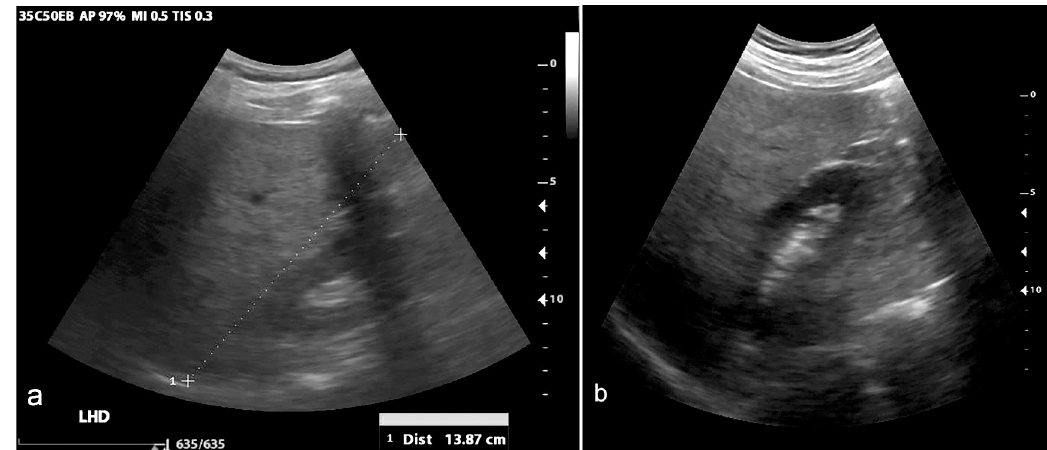
Fig 6. Diffuse hepatic steatosis. Diffuse hepatic steatosis seen on standard of care imaging (a) and VSI (b). In both images there is significant increase in hepatic echogenicity.